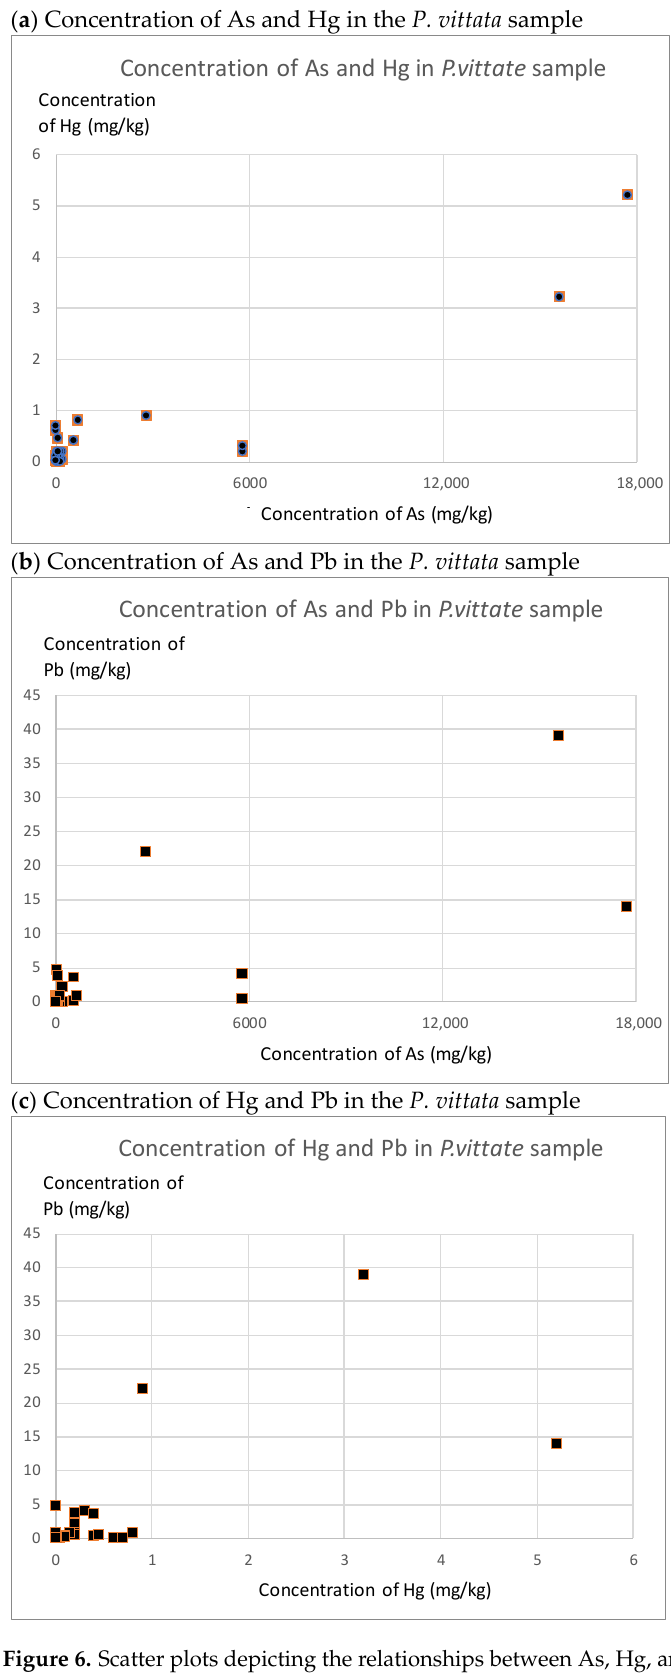
Figure 6. Scatter plots depicting the relationships between As, Hg, and Pb concentrations in P. vittata